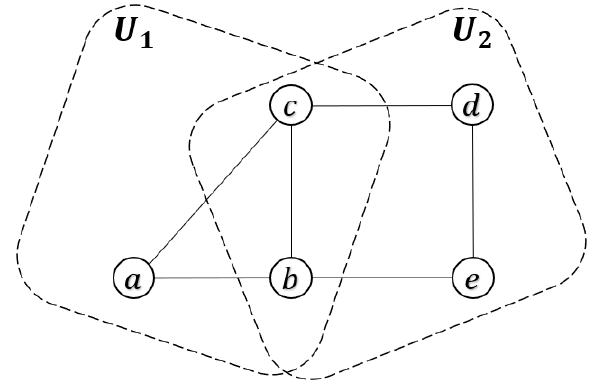
Figure 2. A prime decomposition for an undirected graph G